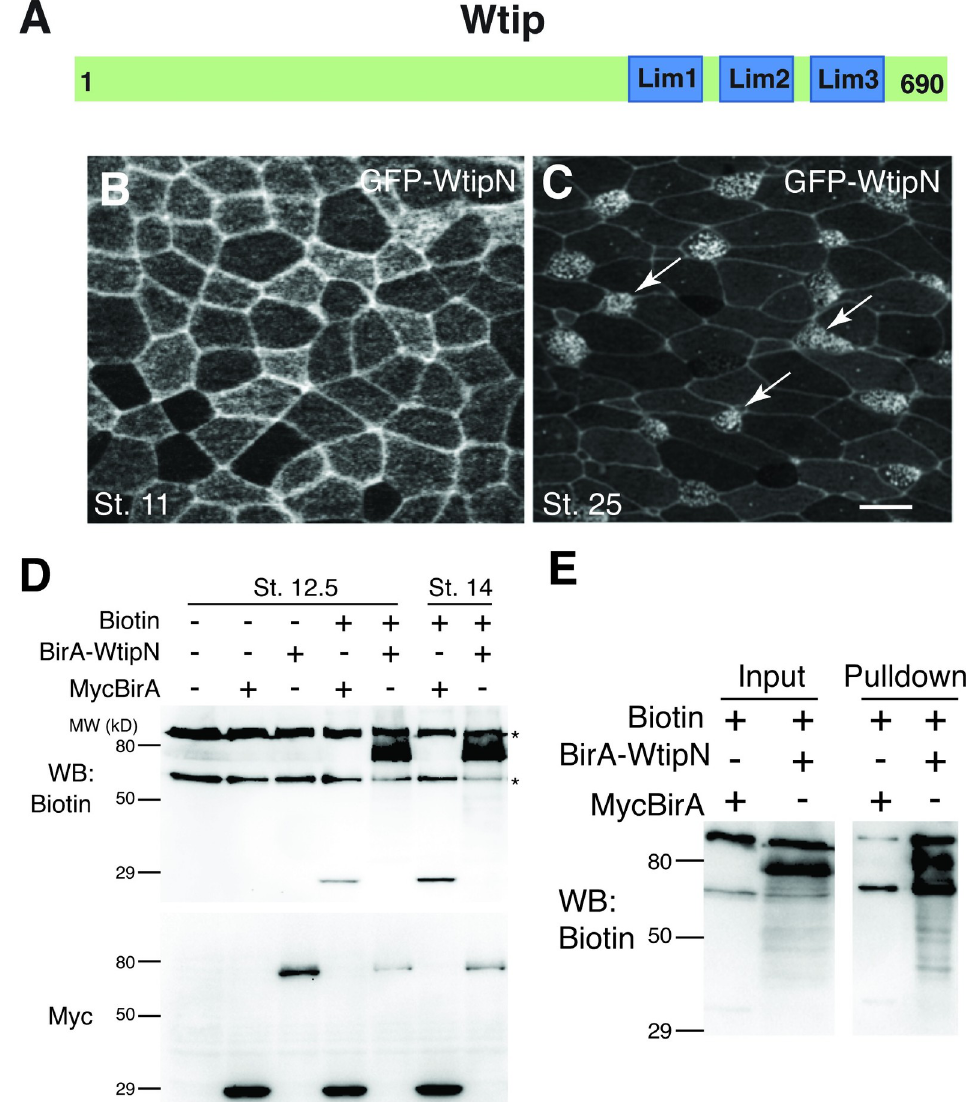
Fig 1. Biotinylation of the BirA-WtipN fusion in Xenopus embryos. A, Schematic of Wtip. B, C, Embryos were injected with 200 pg of GFP-WtipN RNA, fixed and imaged at the indicated stages. B, GFP-WtipN junctional staining in stage 11 ectoderm. C, GFP-WtipN is localized to basal bodies of skin multiciliated cells (arrows, stage 25). Scale bar, 20 μ m. D, Biotinylation of the BirA-WtipN fusion. Four-cell embryos were injected with myc-BirA RNA (300 pg) or mycBirA-WtipN RNA (700 pg) with or without 0.8 mM biotin. Self-biotinylation of mycBirA and mycBirA-WtipN is revealed only in the presence of biotin. Protein levels were assessed with anti-myc antibody. Asterisks indicate endogenous avidin-binding proteins. E. Biotinylated proteins were pulled down with neutravidin beads. In addition to self-biotinylated mycBirA-Wtip, multiple biotinylated bands are detected in the lysates as well as in pulldown.